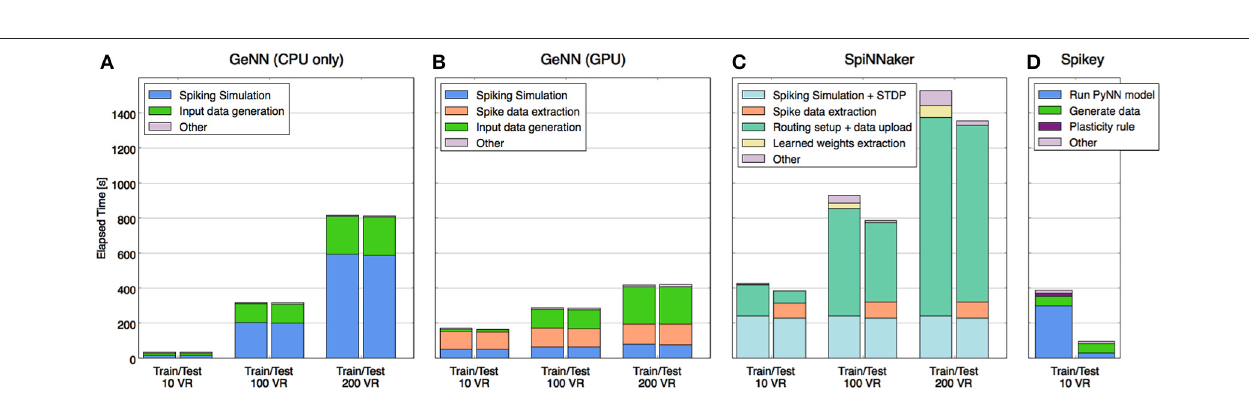
FIGURE 4 | Time taken to perform training and test phases broken down by primary tasks specific to each platform. Tasks that required less time than could be displayed are not shown explicitly (they are grouped into “other”), e.g., the spiking simulation on Spikey. Tasks that accomplish roughly the same job on different platforms are shown in matching colors, whereas some tasks are specific to each of the platforms and are shown in distinct colors. Platforms shown: (A) GeNN with CPU only, (B) GeNN using GPU, (C) SpiNNaker Spinn-3, (D) Spikey.